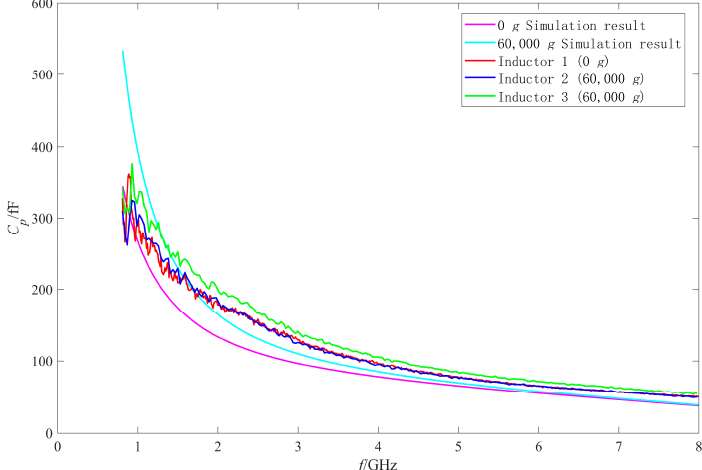
Figure 21. The measured and simulated 𝑅 (cid:3043) of the intact inductors before and after shock test.